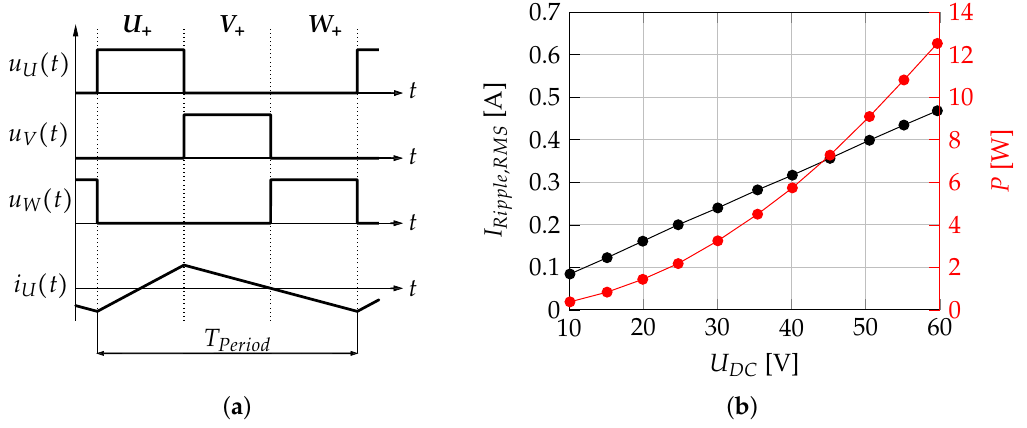
Figure 5. ( a ) 3-Active space vector modulation: Each PWM period contains voltage space vectors from each phase ( U + , V + , W + ). ( b ) Power losses of the bearing due to the current ripple as a function of the DC-link voltage (3-Active SVM, f PWM = 20